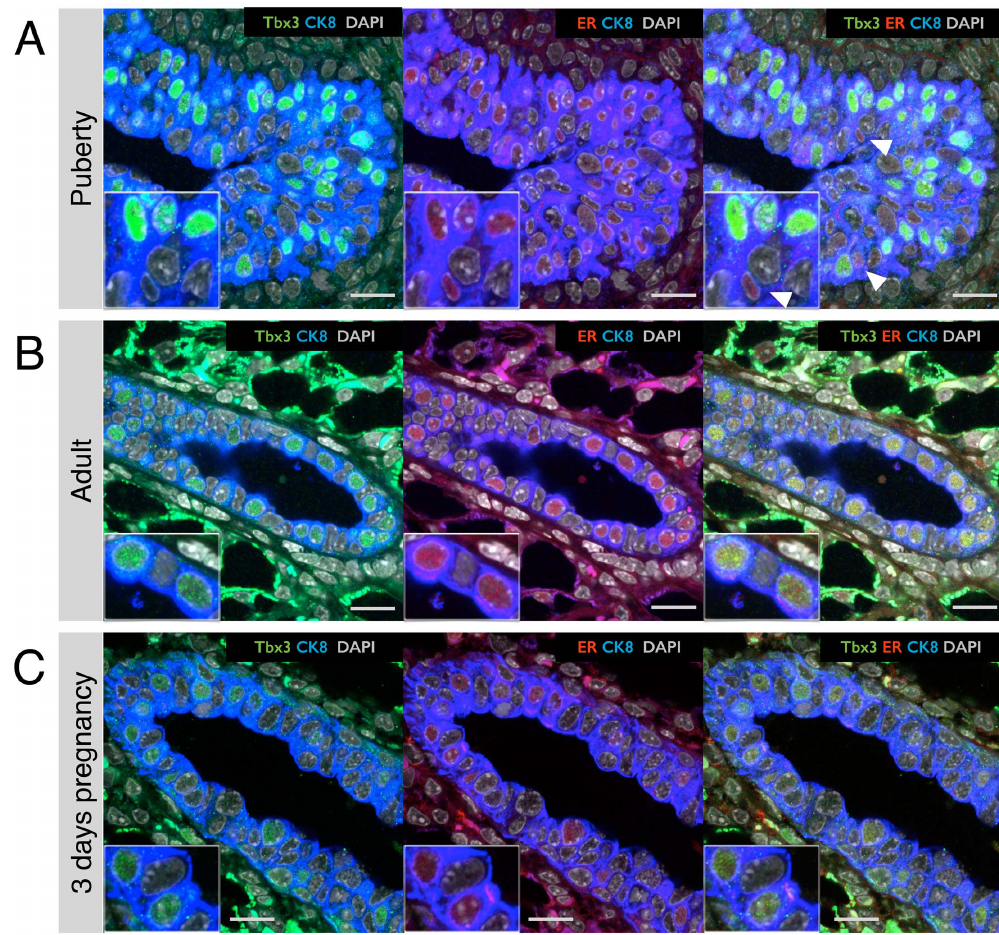
Figure 5. Correlation between Tbx3 and ER expression at different developmental stages of postnatal mammary gland development. Confocal immunofluorescence staining of Tbx3 (green), ER (red) and luminal marker cytokeratin-8 (CK8, blue) on mammary glands from (A) 5-week old pubertal mice (terminal end bud structure), (B) 10-week old virgin mice (ductal structure) and (C) 3 day pregnant mice (ductal structure). Nuclei are stained with DAPI (grey). White arrow heads indicate cells in terminal end bud (A) with ER expression but no Tbx3 expression. Images are representative of staining performed on paraffin sections of 3 independent animals. Scale bar is 20 m m.